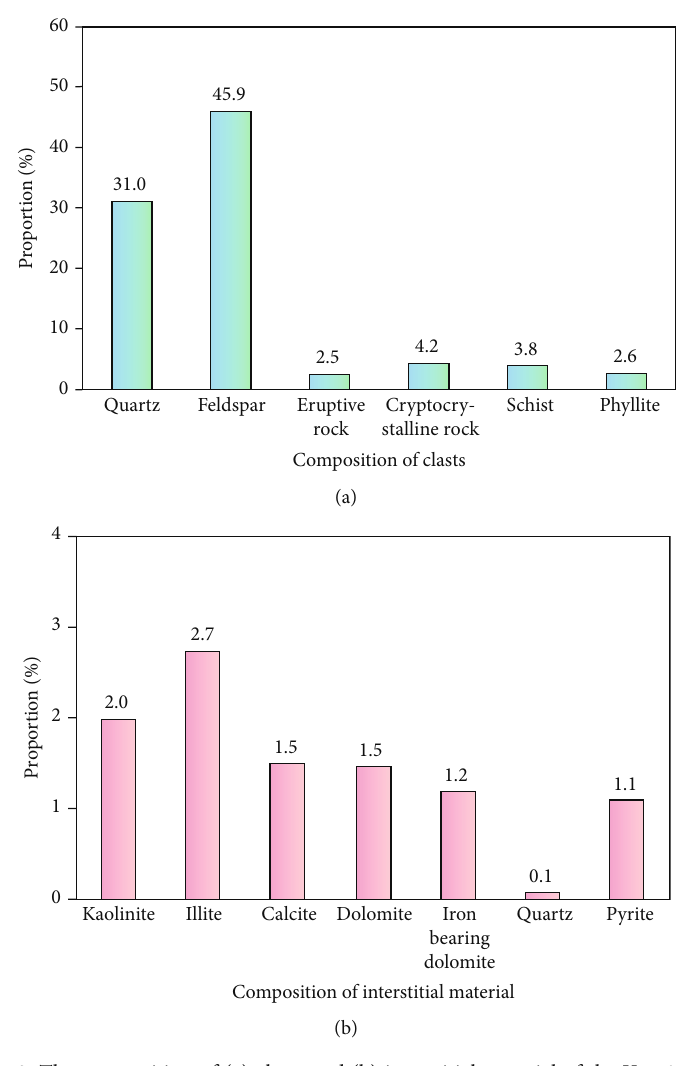
Figure 3: The composition of (a) clasts and (b) interstitial material of the Yan 9 32